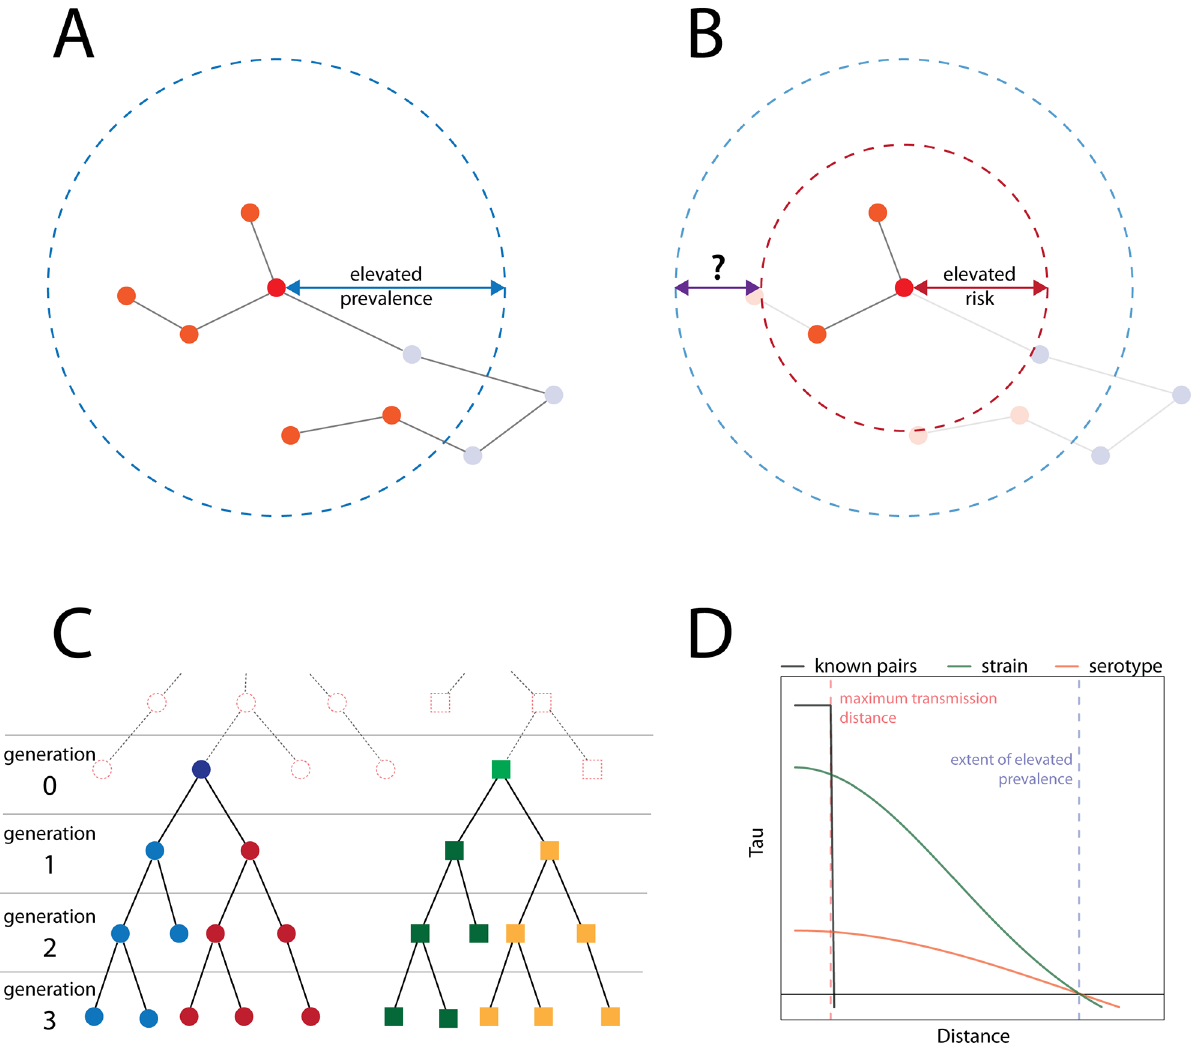
Fig 1. The transmission kernel determines the spatial area where directly transmitted cases may be found (area of elevated risk, red circle in (B) ). In addition, due to branching in the transmission chain there may be a larger area of elevated prevalence from more distally related cases (area of elevated prevalence, blue circle in (A) and (B) ). (C) Example transmission chains. Each color represents a transmission chain of a different strain. The strains are divided into two serotypes, with the blue and red circles representing one serotype and the green and yellow squares a second serotype. (D) Increasing ability to discriminate between different transmission chains will increase the power of the τ -statistic to identify the spatial extent of elevated prevalence. Where case-pairs are known, we can identify the area of elevated risk (black